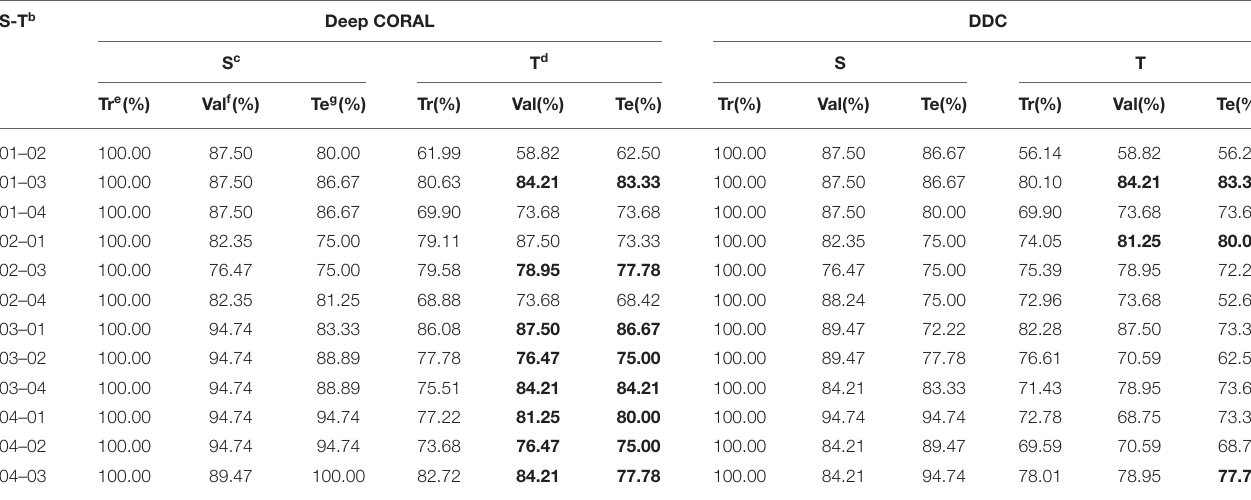
TABLE 4 | Classification results of deep CORrelation ALignment (CORAL) and deep domain confusion (DDC) ( fc 6 a ). S-T b Deep